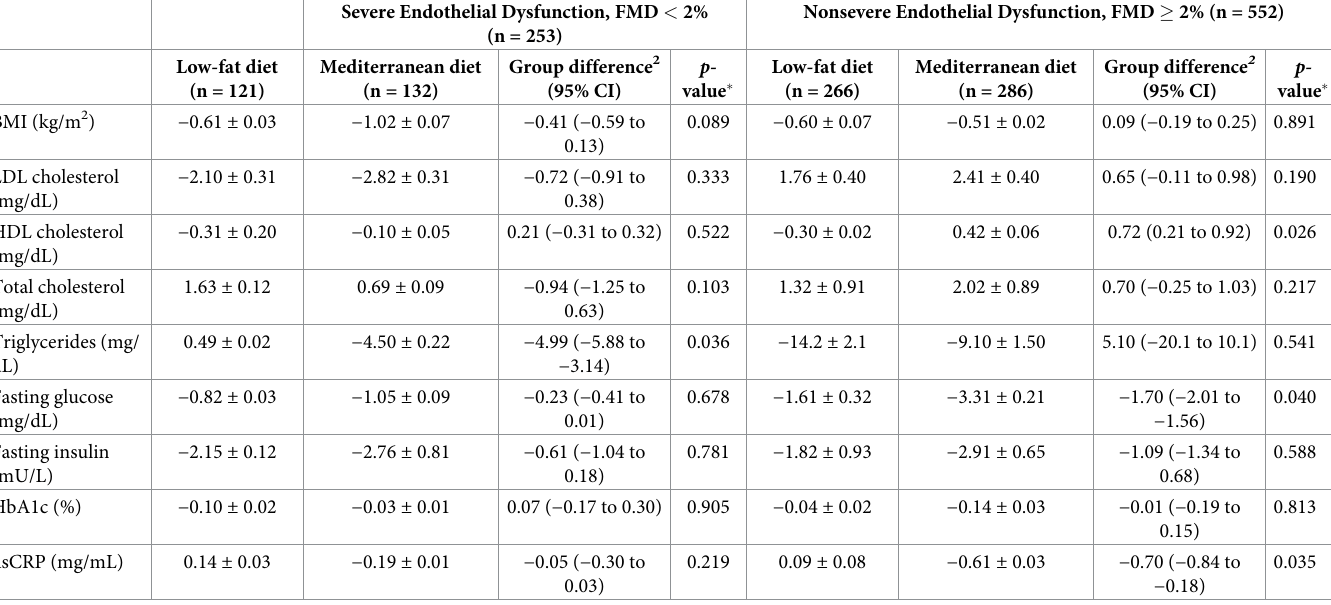
Table 3. Effect of dietary intervention on anthropometric and biochemical markers ( Δ changesproduced between post- and preintervention) in CHD patients classi- fied according to the severity of endothelial dysfunction 1 . Severe Endothelial Dysfunction, FMD < 2% (n =